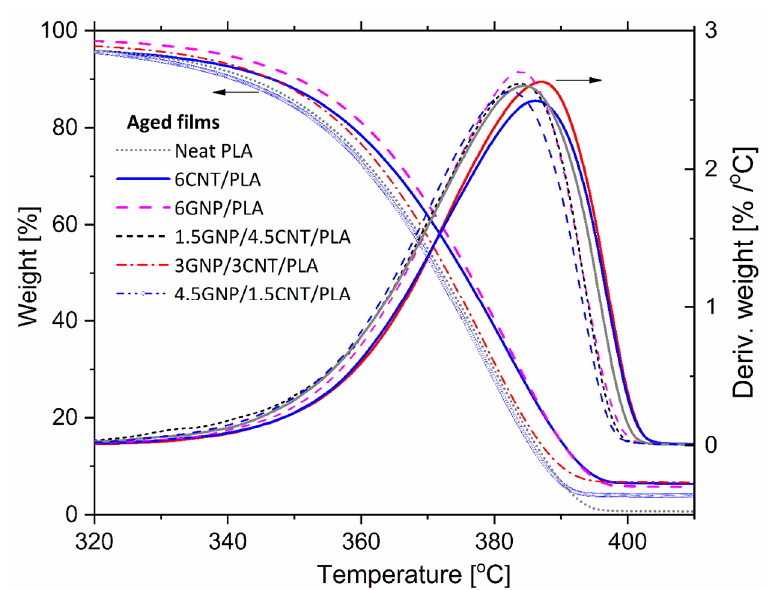
Figure 4. DSC thermograms of the “annealed” aged films at 80 °C for 4 h: ( a ) first heating run at 10 °C/min, and ( b ) subsequent slow cooling of the melt at 1 °C/min after the first heating run.